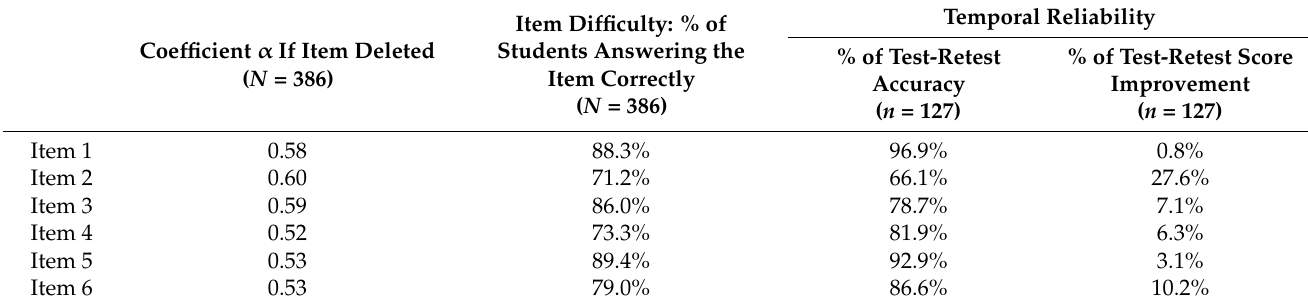
Table 4. Internal consistency (coefficient α ) and reproducibility of the NVS-PTeen given as temporal reliability.